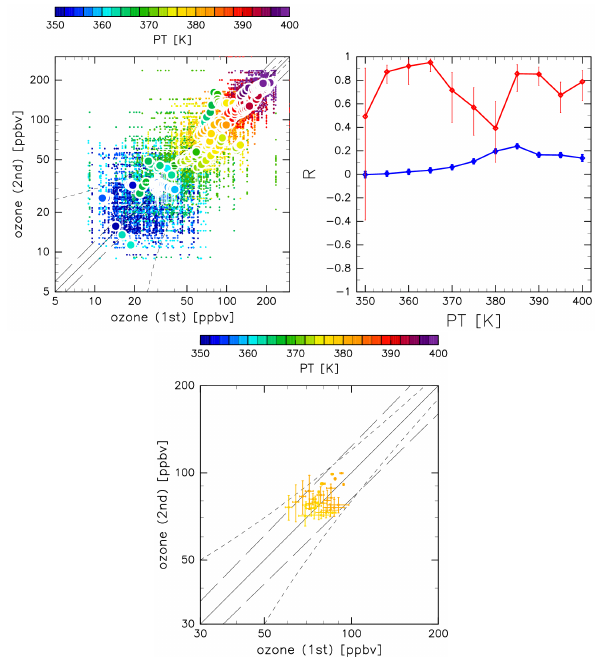
Fig. 3. Left: As for the left panel in Fig. 2 but for preliminary matches for which the time interval between the first and second observations is less than 3 days (large circles). The small dots rep- resent all of the possible paired (see the text for details on the pairing procedure) observations (to reduce clutter, not all data are shown). Center: Correlation coefficients calculated for every 5K of potential temperature (with ± 2 . 5K bins) for the preliminary matches (red) and for all possible paired observations (blue). Error bars are 90% confidence intervals. Right: As for the large circles in the left panel but for pairs at altitudes from 377.5K to